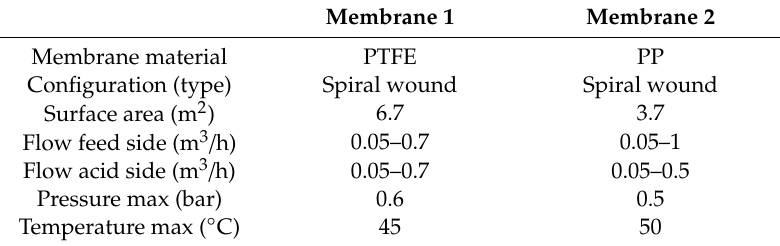
Table 7. Summary of the specifications for the membrane modules